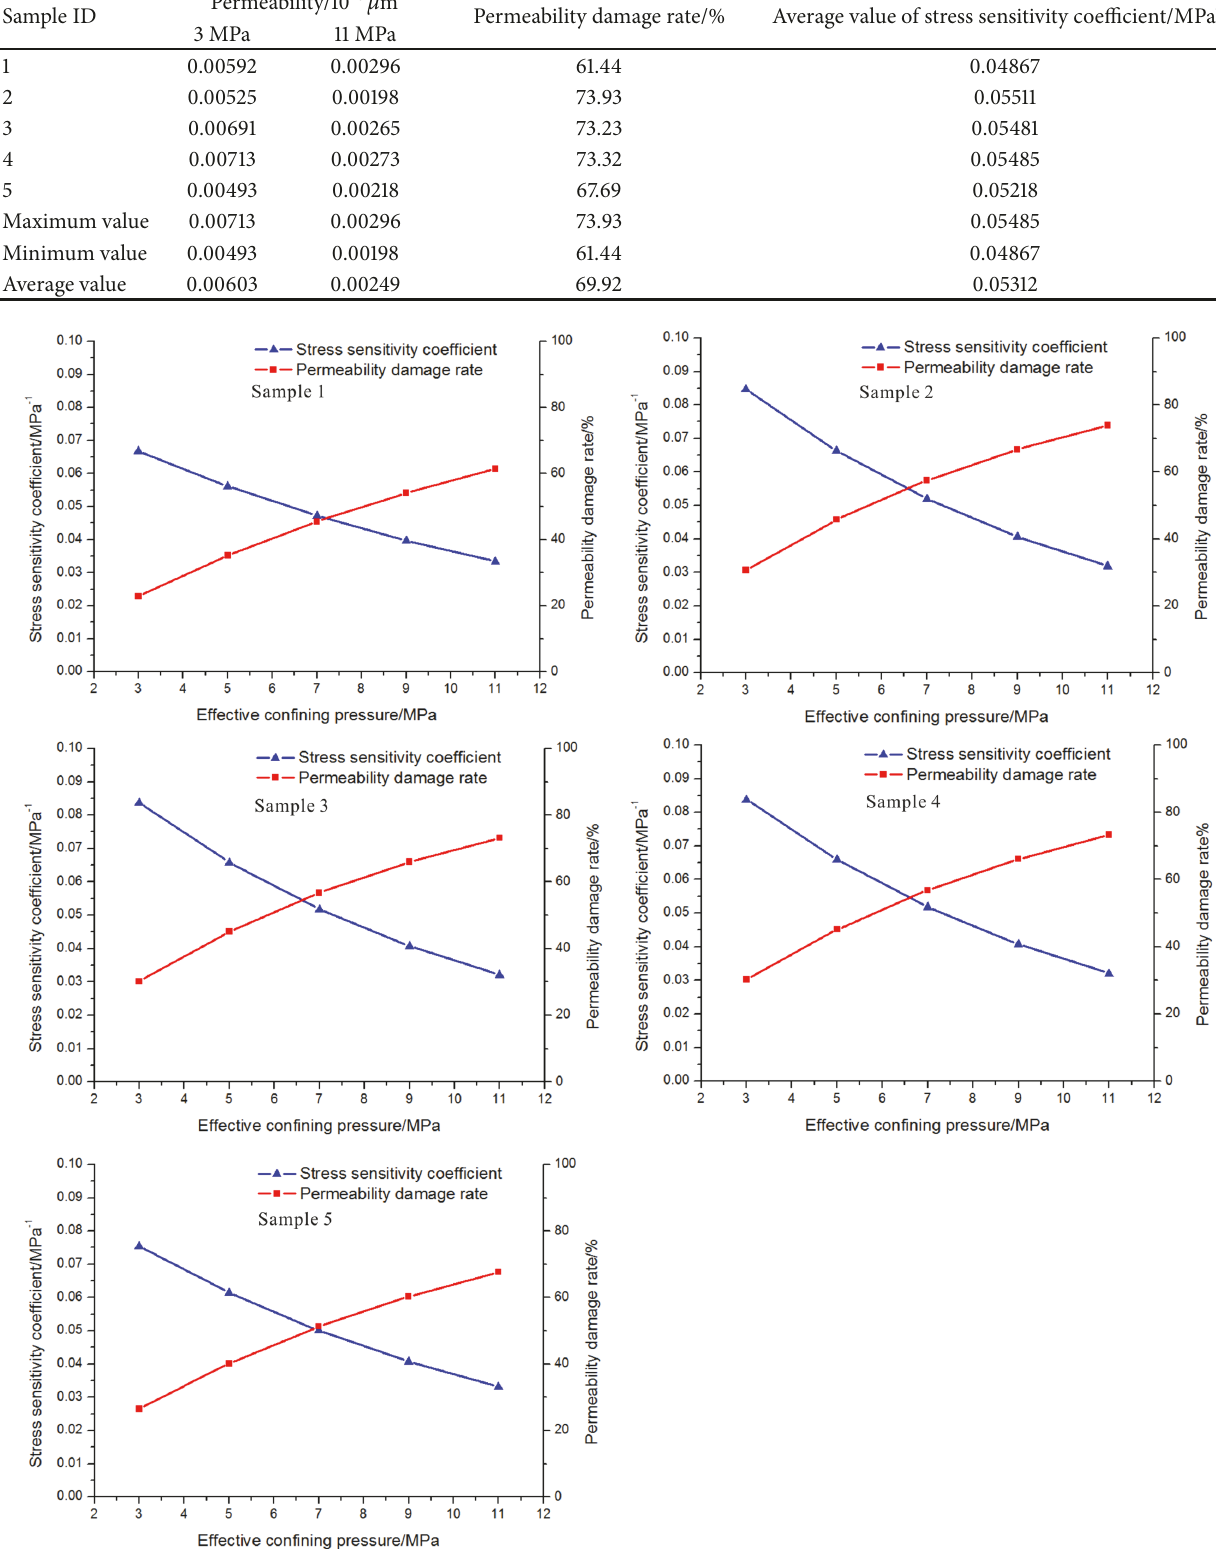
Figure 2: Relationships of the permeability damage rates and stress sensitivity coefficient with the effective